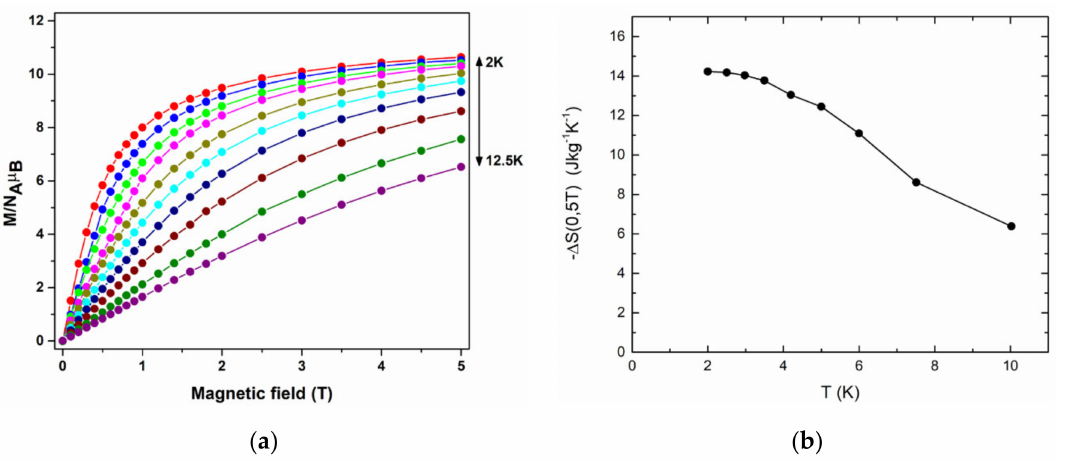
Figure 5. ( a ) Field dependent isothermal magnetization of 3 in the temperature range 2–12.5 K. ( b ) A plot of the maximum entropy change from 0 to 5 Tesla, against temperature for 3 , calculated from the Equation (5). Solid lines are guide to the